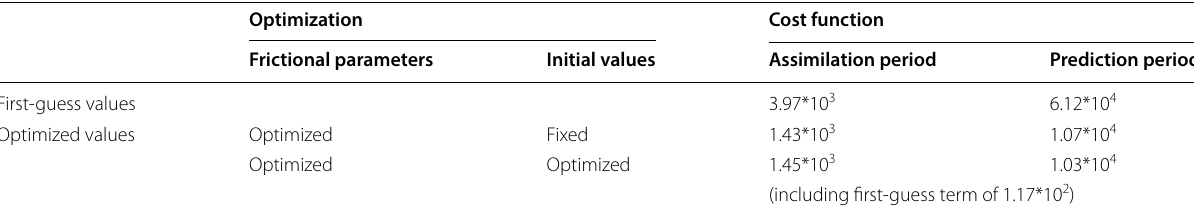
Table 2 Values of cost functions calculated by using Eq. (7) in the case of real GNSS time